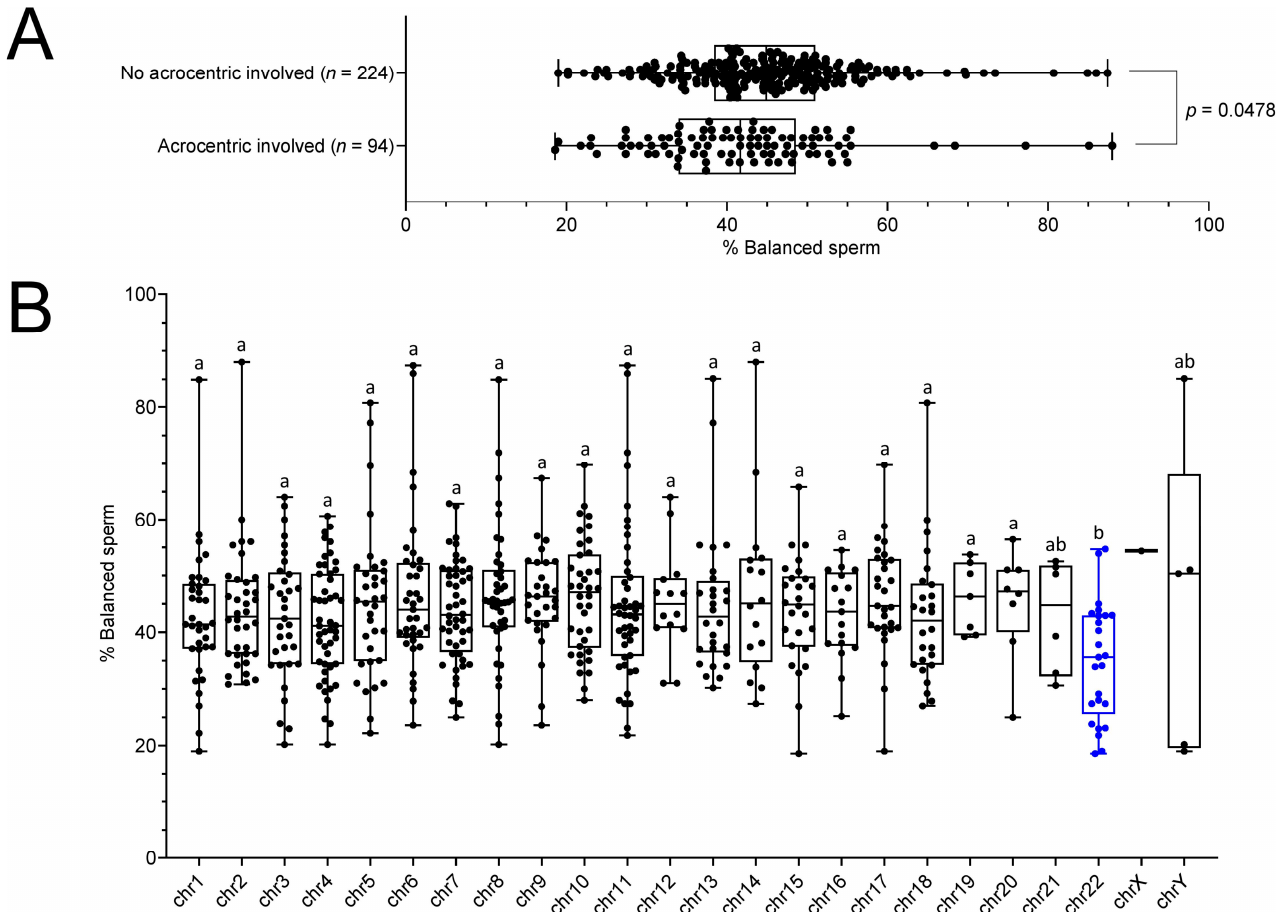
Figure 4. Acrocentric chromosomes, especially 22, reduce the balanced sperm rates. The rate of balanced cells is reduced ( A ) when an acrocentric chromosome is involved in the translocation, ( B ) especially chromosome 22 (blue) whose presence is associated with higher rates of imbalance. Each chromosome was compared individually with all other chromosome one by one. For each chromosome, plots sharing different small letters represent statistically significantly differences between the groups (p < 0.05), and plots with a common letter do not present statistically significantly differences between the groups (p > 0.05). Corresponding statistical data can be found in the Supplementary Materials Tables S5 and S6.